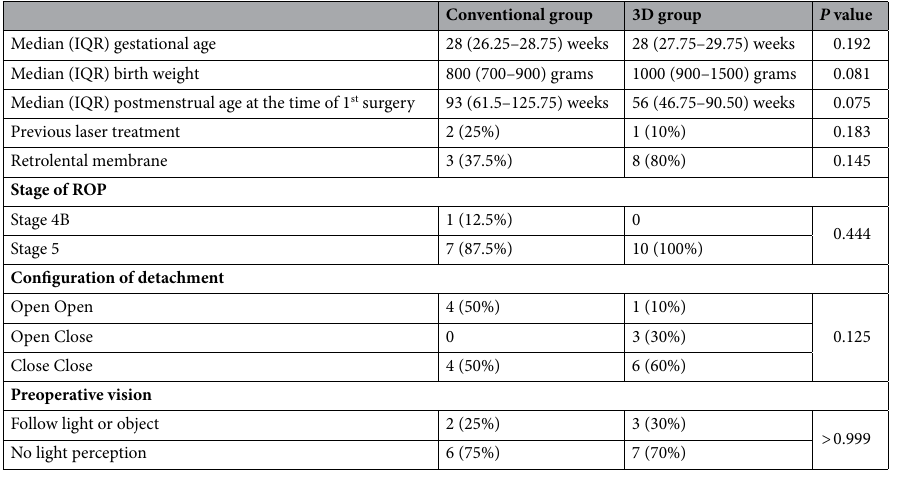
Table 1. Preoperative characteristics comparison between both groups. IQR interquartile range, ROP retinopathy of